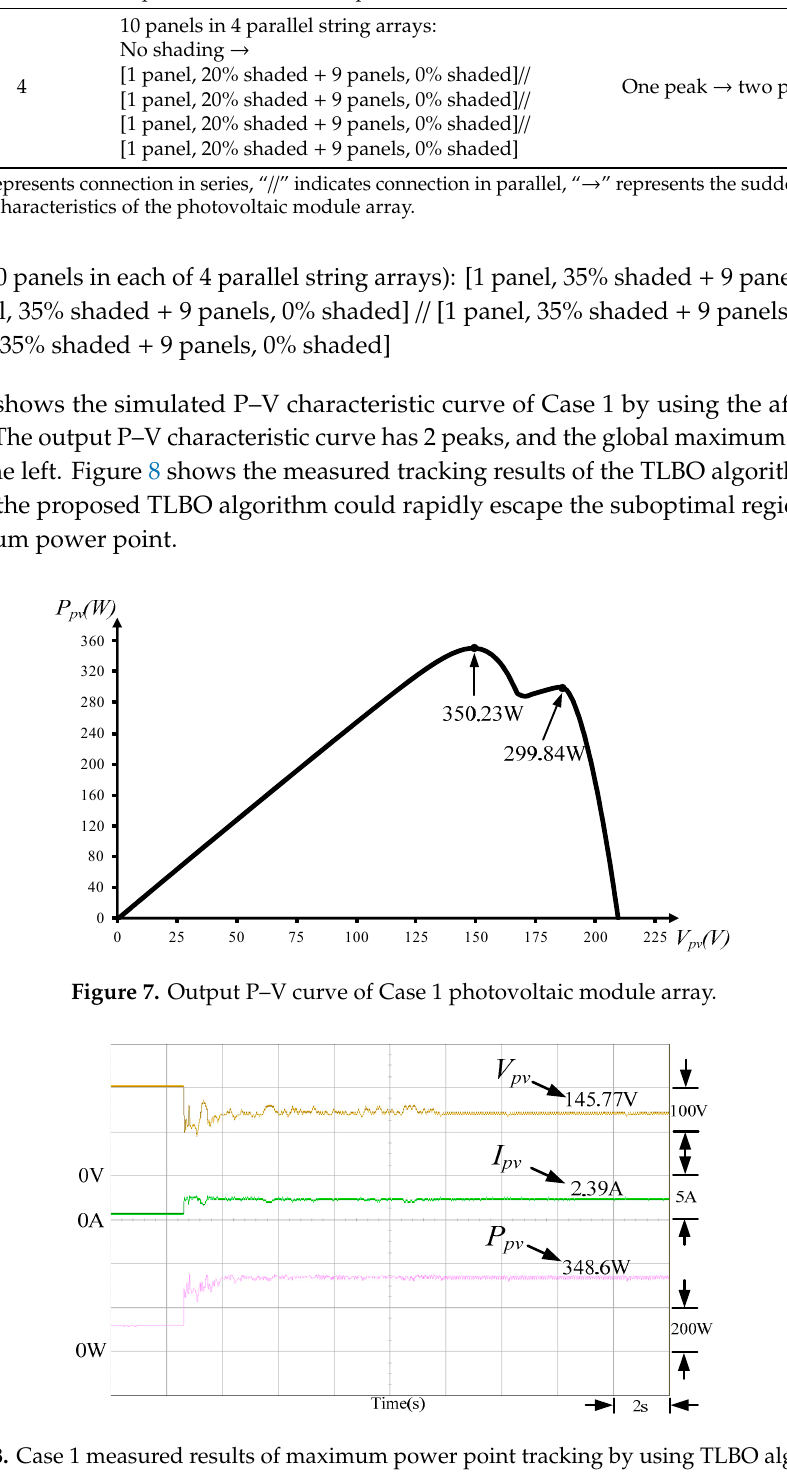
Figure 8. Case 1 measured results of maximum power point tracking by using TLBO algorithm.